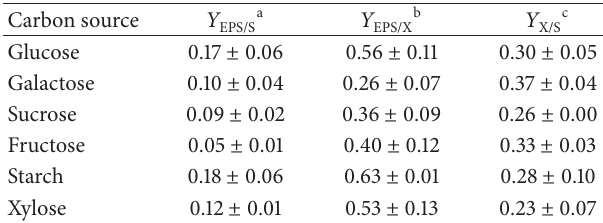
Table 3: Biomass and product formation yields from the different C sources used by S . degradans growing on BM medium (two replicates).